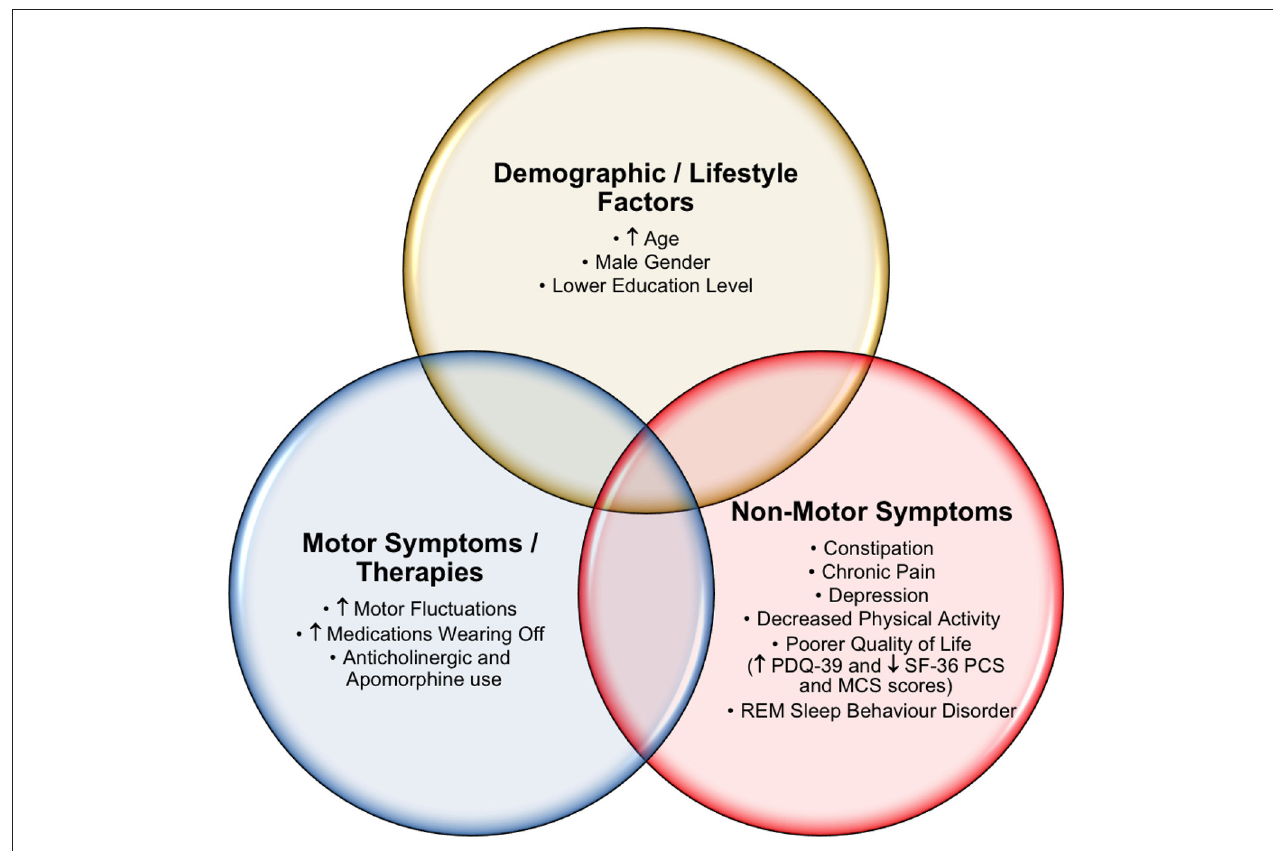
FIGURE 1 | Factors associated with impaired cognition in Parkinson’s